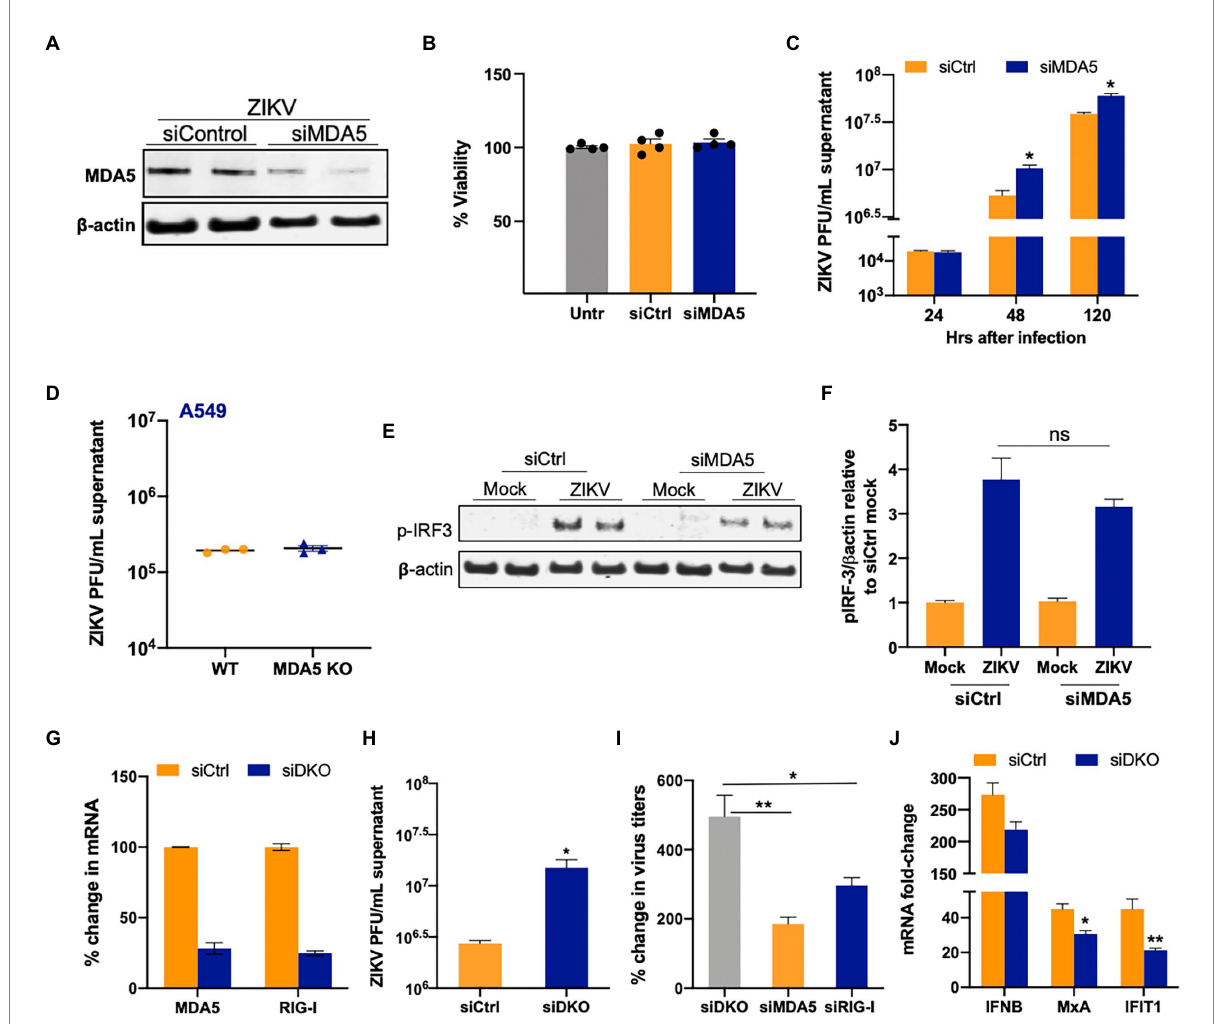
FIGURE 4 Silencing of MDA5 increases ZIKV replication in SC. (A) SC were transfected with siRNA specific for siMDA5 or siCtrl and silencing efficiency was determined by measuring MDA5 protein levels using Western blot at 48 hpt. (B) Percent change in the cell viability of siCtrl and siMDA5 transfected SC at 48 hpt was calculated as compared to untreated cells. (C) SC were infected with ZIKV (MOI 1) at 48 hpt and ZIKV PFU were determined by plaque assay at different time points, expressed as PFU/mL supernatant. (D) WT and MDA5 knockout A549 were infected with ZIKV (MOI 1) and virus titers in the supernatants were determined by plaque assay at 48 hpi. (E) The effect of siMDA5 on phosphorylated IRF3 (p-IRF3) protein expression was determined in both mock-and ZIKV-infected SC at 48 hpi by Western blotting. (F) Densitometry analysis was performed to quantify western blot data and expressed as the ratio of p-IRF3/ β -actin in infected cells relative to the siCtrl mock. (G) SC were co-transfected with siMDA5, and siRIG-1 (exon 11), and knockdown was determined by measuring mRNA transcripts. (H) ZIKV titers in the supernatants from siCtrl and double knock-down (DKD) with siMDA5 and siRIG-I cells were determined by plaque assay at 48 hpi and expressed as PFU/mL supernatant. (I) Percent increase in ZIKV titers in SC transfected with siRIG-I and siMDA5 compared to siCtrl at 48 hpi. (J) Gene expression of IFNB1, MXA, and IFIT1 was determined at 48 hpi using qRT-PCR. Data was normalized using GAPDH and fold change was calculated compared to respective mock-infected cells. Data represent mean ± SEM from at least 3–5 independent experiments. * p < 0.05; ** p <